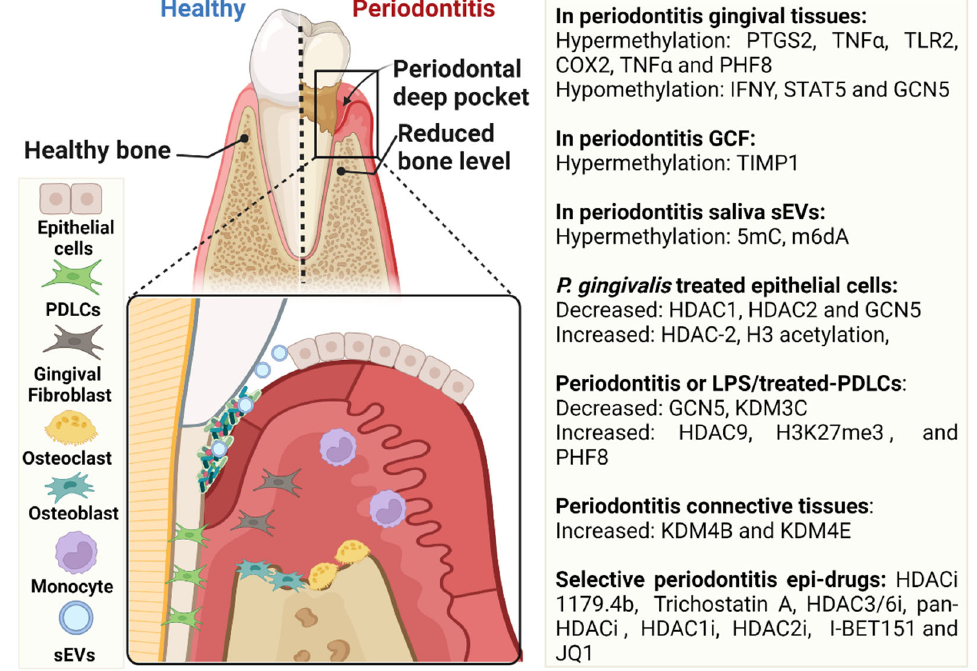
Figure 3. Summary of key epigenetic modulators of DNA methylation and HDACs during periodontitis pathogenesis and periodontal cells under inflammatory microenvironment.